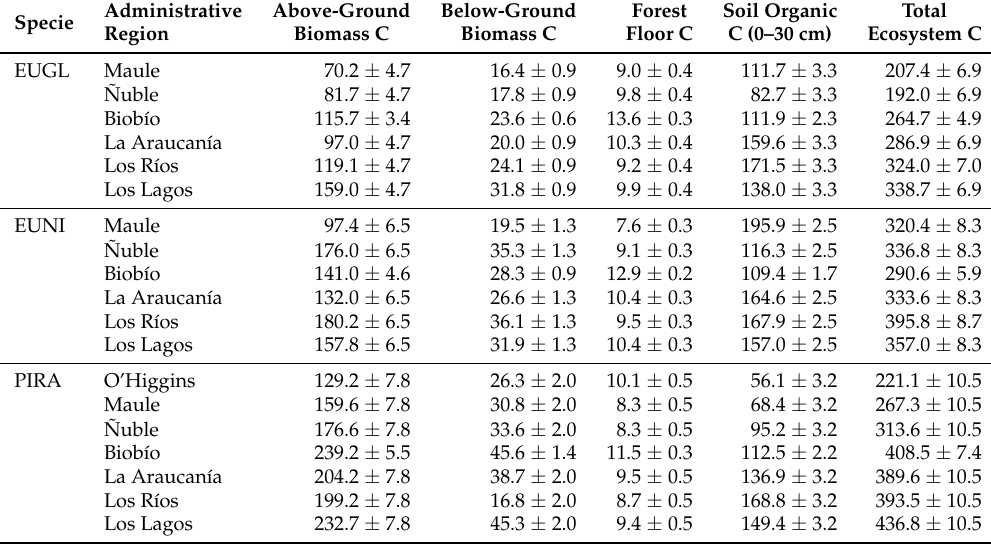
Table A4. Average ( ± standard deviation, n = 11,084) carbon stocks [Mg · ha − 1 ] for each administrative region for each specie at rotation age (10–14 years-old for EUGL and EUNI, 20–24 years-old for PIRA).